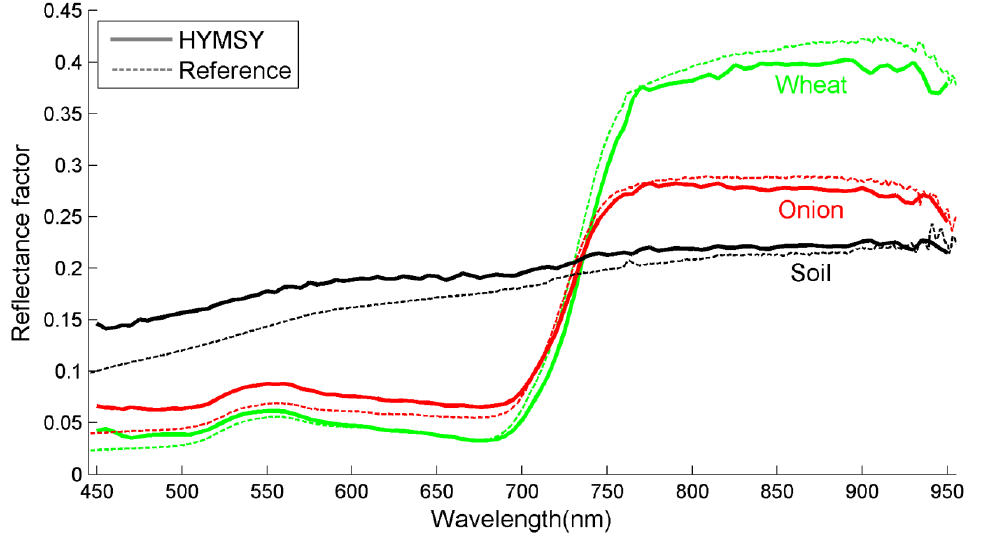
Figure 5. Comparison of HYMSY spectra and ground reference ( ASD FieldSpec HandHeld 2 ) spectra. The HYMSY spectra were picked from the datacube shown in Figure 4 by averaging pixels over a small area (10–100 pixels) close to the